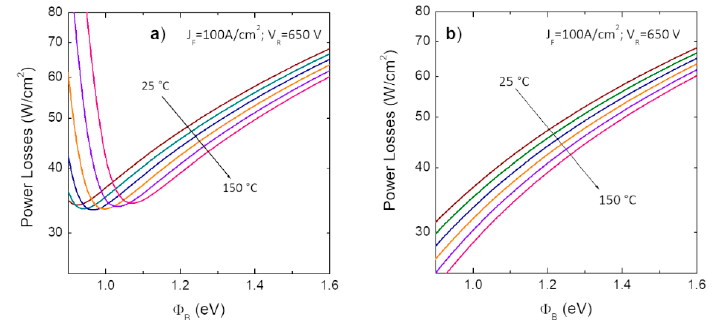
Figure 5. Schottky barrier height dependence of the static power losses for ( a ) a conventional Schottky diode and ( b ) a modern JBS diode, in the temperature range 25–150 °C. The curves were simulated by considering the forward electrical behavior ruled by thermionic emission model and the reverse characteristics ruled by thermionic field emission model. In the case of the JBS diode ( b ), the leakage current contribution has been neglected.